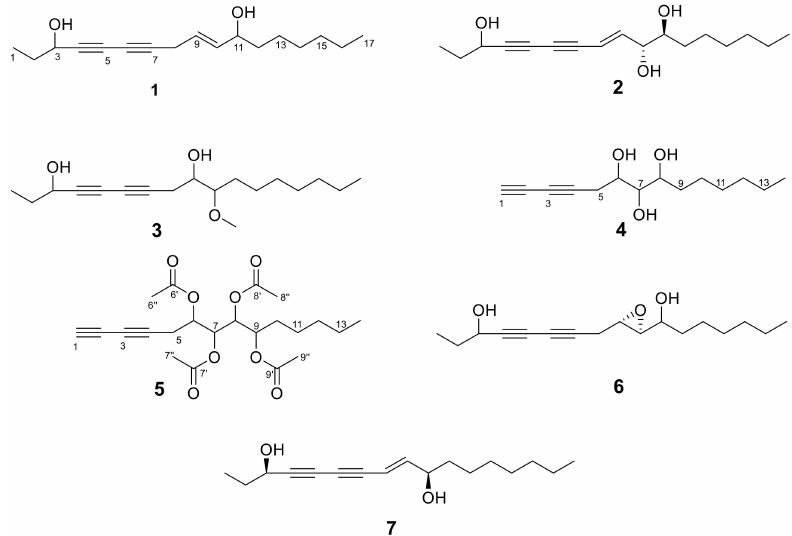
Figure 1. Structures of compounds 1 – 7